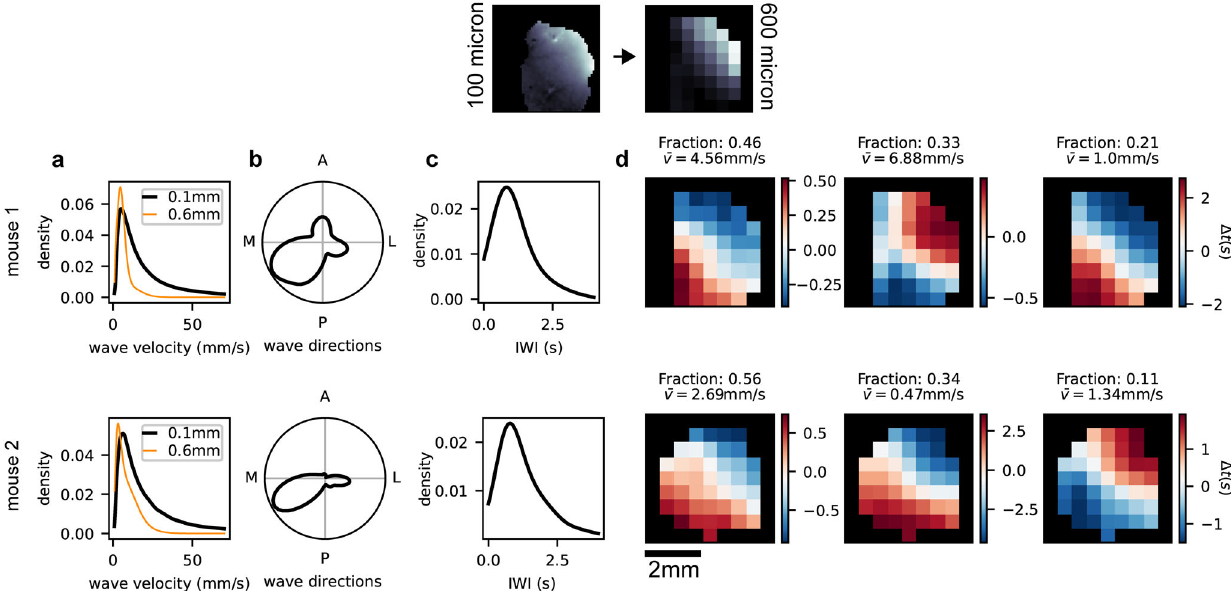
Fig. 2 Summary of wave propagation properties in experimental trials for two different mice. Measures for the quantitative characterization and comparison of waves accumulated across all pixels and all trials in mouse 1 (upper row) and 2 (lower row), respectively. a Local wave velocity distributions measured over the original dataset at a spatial resolution of 0.1 mm (black thick line) and the one downsampled at a spatial resolution of 0.6 mm (orange thin line). b Local wave direction distributions. c Local inter-wave interval distributions. d . Wave propagation modes identi fi ed by Gaussian Mixture Model (GMM). The GMM classi fi cation algorithm returns the optimal number of clusters appropriate for grouping the waves identi fi ed in the observed dataset, then assigning each wave to a cluster, assuming each cluster is described by a multivariate Gaussian distribution in the channel space (with its mean vector and covariance matrix). Distributions in panels a , b and c are at the original resolution (100 μ m), while before application of GMM the channel-space dimension has been reduced to 600 μ m (see the original resolution compared to the downsampled one on top of the main panels). For comparison, in panel a the velocity distribution is also reported for the downsampled signal. In the experimental data, three different wave propagation modes for each mouse are identi fi ed. The spatio-temporal propagation dynamics of each mode is normalized to the temporal center of each wave (from blue to red